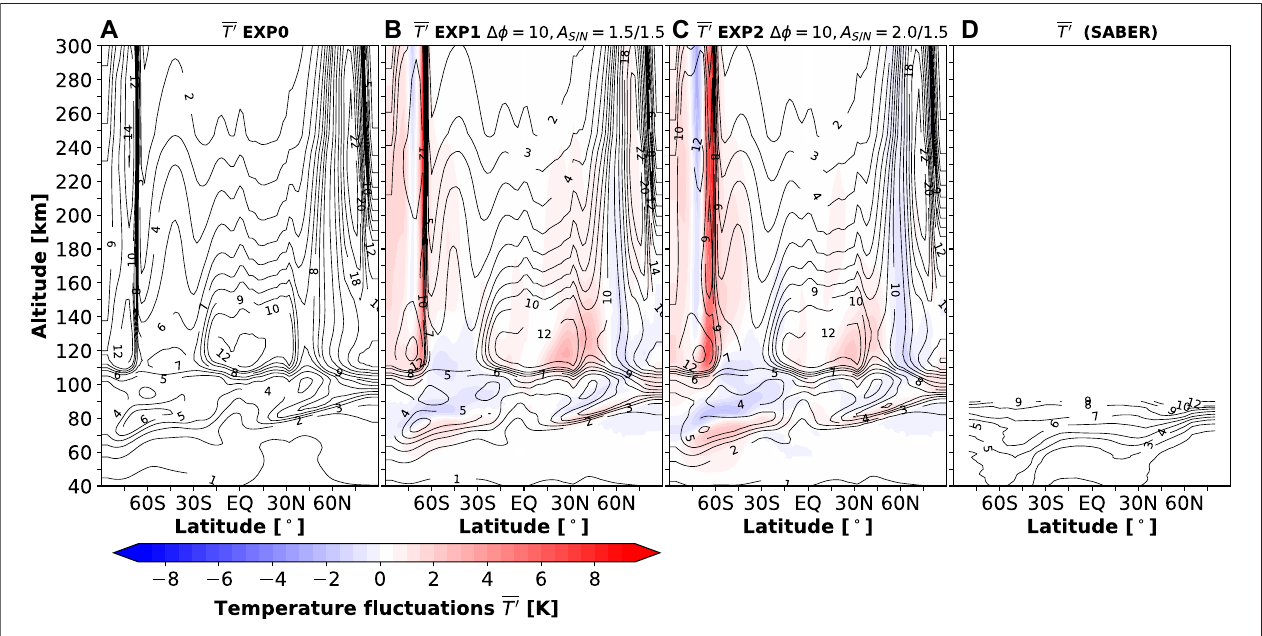
FIGURE 6 | same as in Figures 4A – C , but for the GW-induced temperature fl uctuations | T ′ | . The SABER GW activity is shown in panel (D). The contour intervals are 1 K between | T ′ | (cid:2) 1 − 9 K and 2 K between | T ′ | (cid:2) 10 − 22 K.